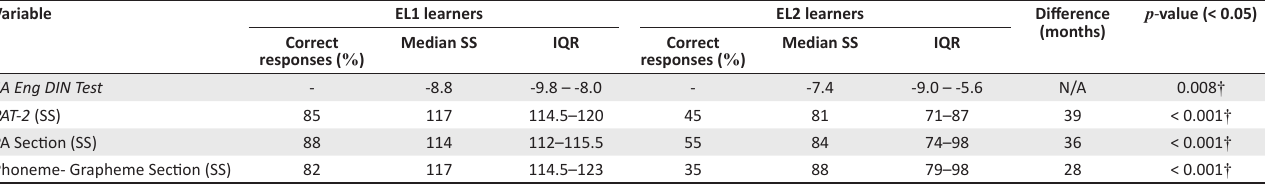
TABLE 1: SA Eng DIN Test , total PAT-2 and section scores: Percentages, medians and interquartile ranges of English first language and English second language learners. Variable EL1 learners